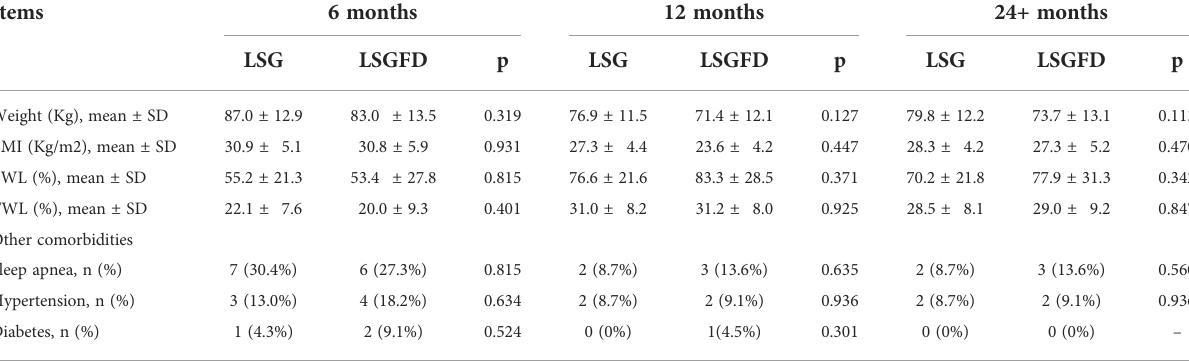
TABLE 5 Results of